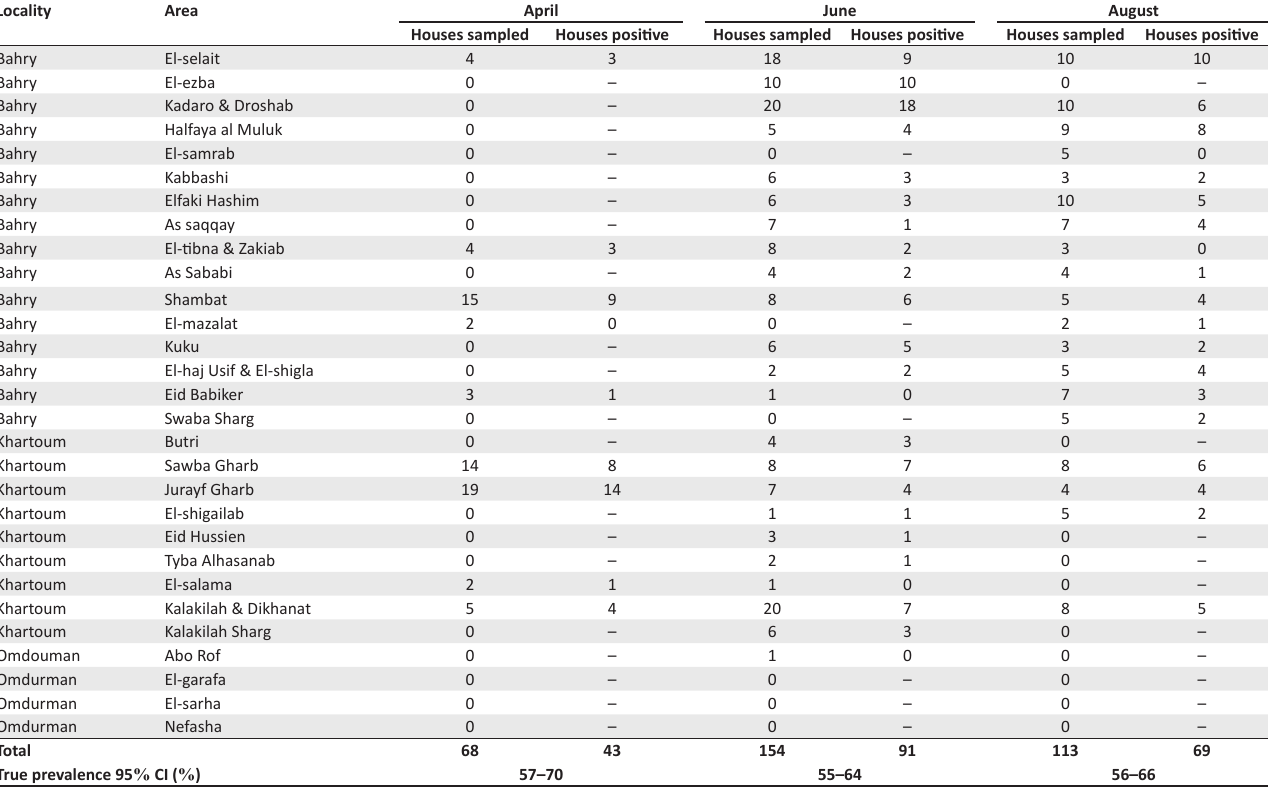
TABLE 1: Number of houses sampled in 2008 and found positive for antimicrobial residues in each area sampled with 95 % confidence interval for the true prevalence of houses with residues for each period sampled given below. Locality